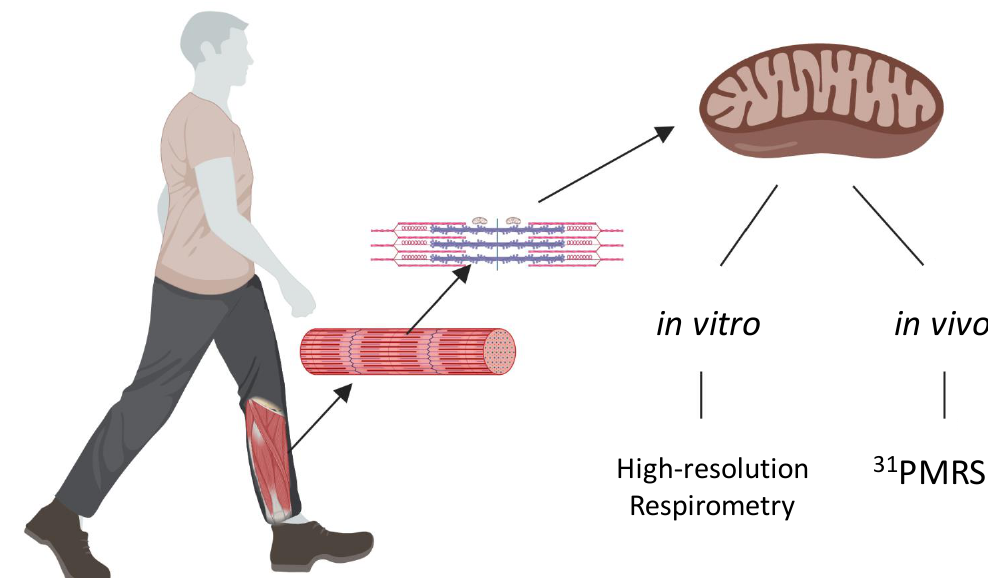
Figure 2. Mitochondrial oxidative phosphorylation capacity is comprised of both number and function that can be measured in vivo or in vitro. Mitochondria within skeletal muscle measured in vivo can be measured via phosphorus magnetic resonance spectroscopy ( 31 PMRS). 31 PMRS infers function from measures of mitochondrial oxidative phosphorylation (MOP) capacity, that when paired with V MITO quantitatively describes function. Mitochondrial function in vitro can be measured via high-resolution respirometry following isolation of the organelle from the tissue. Created with Biorender.com.